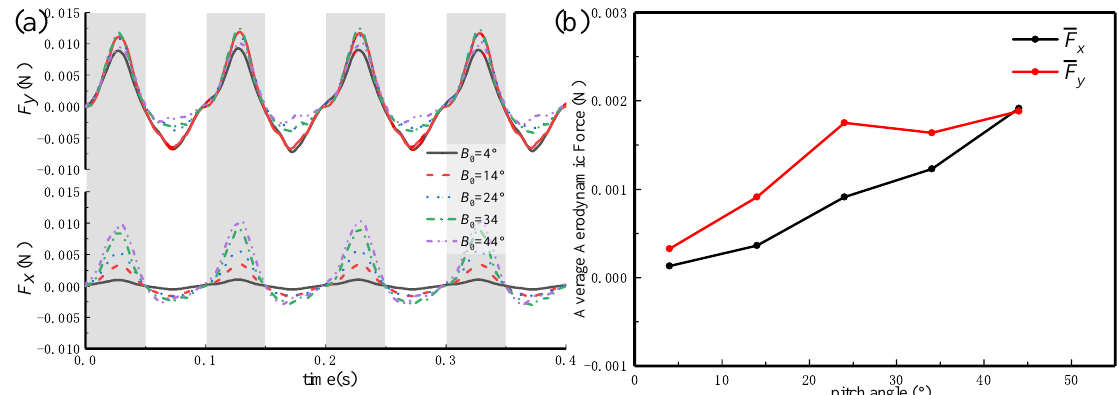
Figure 8. ( a ) The instantaneous aerodynamic forces of the butterfly accompanied by the change of B 0 in four flapping cycles; and ( b ) the average aerodynamic forces at different fixed pitch